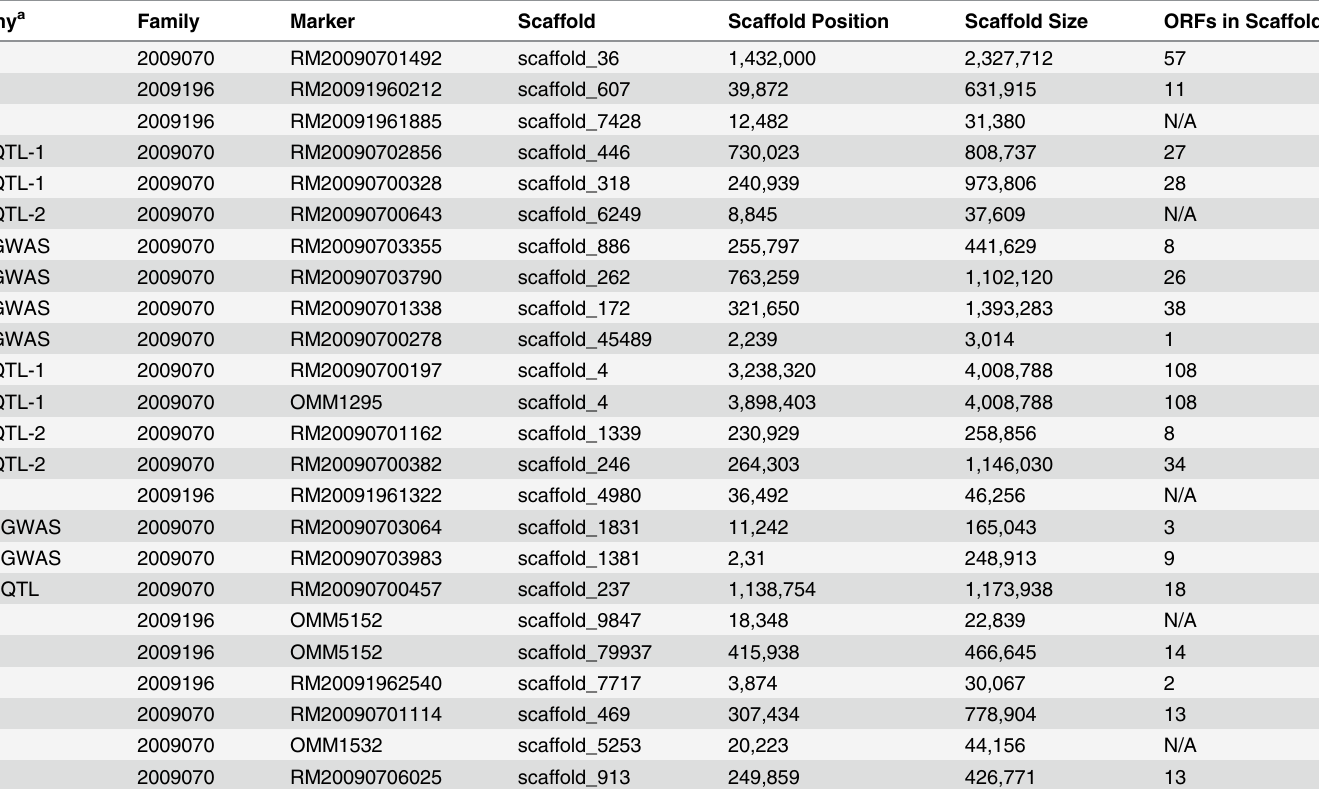
Table 3. Rainbow trout genome scaffolds [22] matched by markers linked to BCWD resistance QTL. Omy a